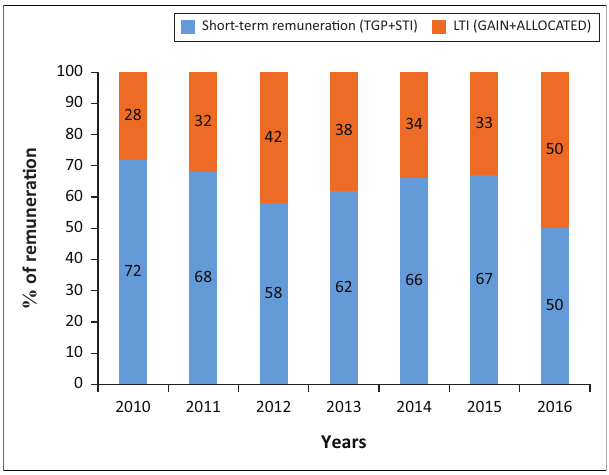
FIGURE 3: Breakdown of annual remuneration.